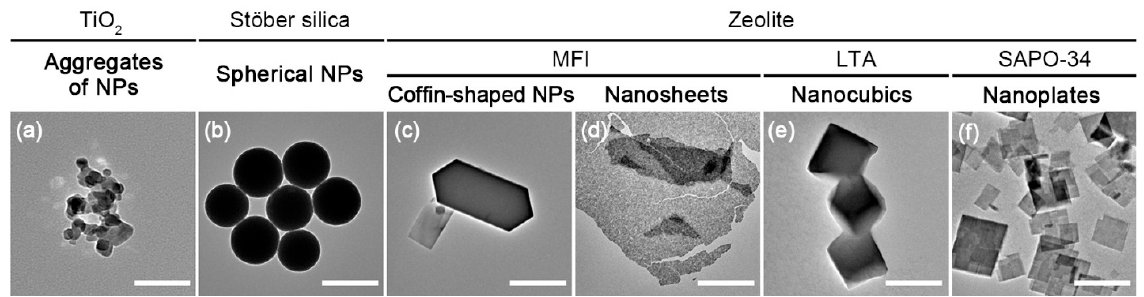
Figure 1. TEM images of various shapes of nanoparticles (NPs). ( a ) Aggregates of NPs, ( b ) spherical NPs, and ( c ) coffin-shaped NPs, ( d ) nanosheets, ( e ) nanocubics, and ( f ) nanoplates. The scales are 100 nm for ( a ), 500 nm for ( b ), and 1 μ m for ( c – f ).